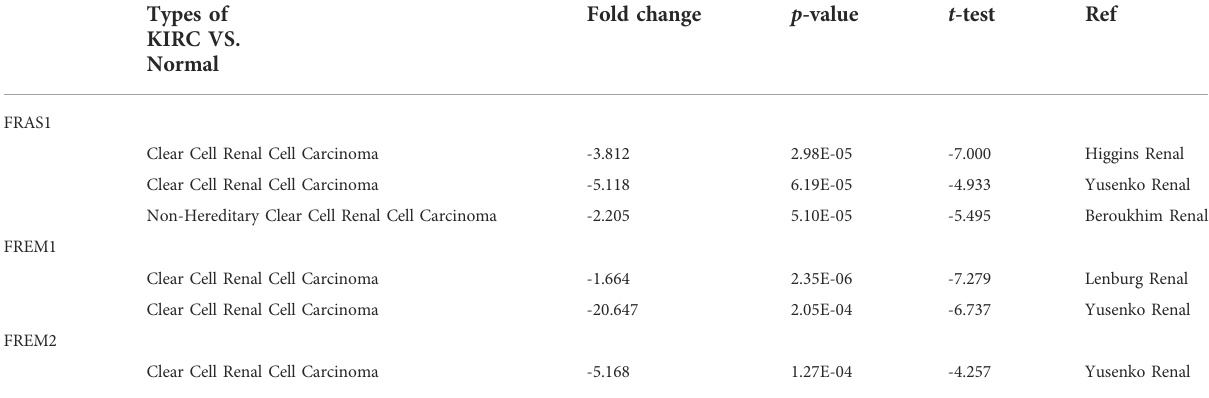
TABLE 1 Differential expression of FRAS1/FREM family members in KIRC tissues and normal kidney tissues in the Oncomine database. Types of KIRC